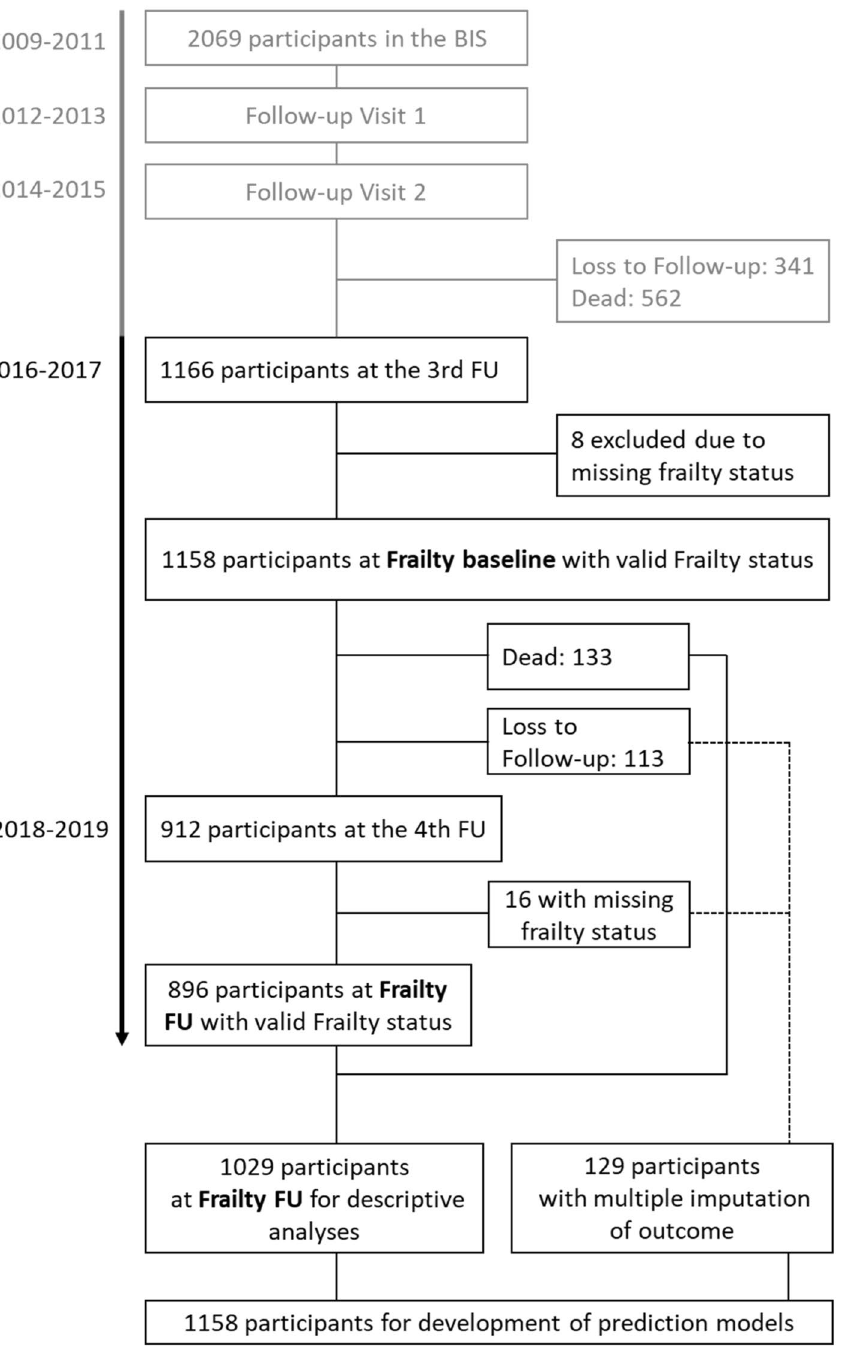
Figure 1. Overview of the Berlin Initiative Study (BIS) population. The flowchart shows the composition of the study population and which participants were available for certain analyses. The light gray section of the figure indicates the part of the BIS study that preceded this study. The frailty assessment was implemented at the 3rd follow-up (FU) of the BIS, defining the baseline visit for this